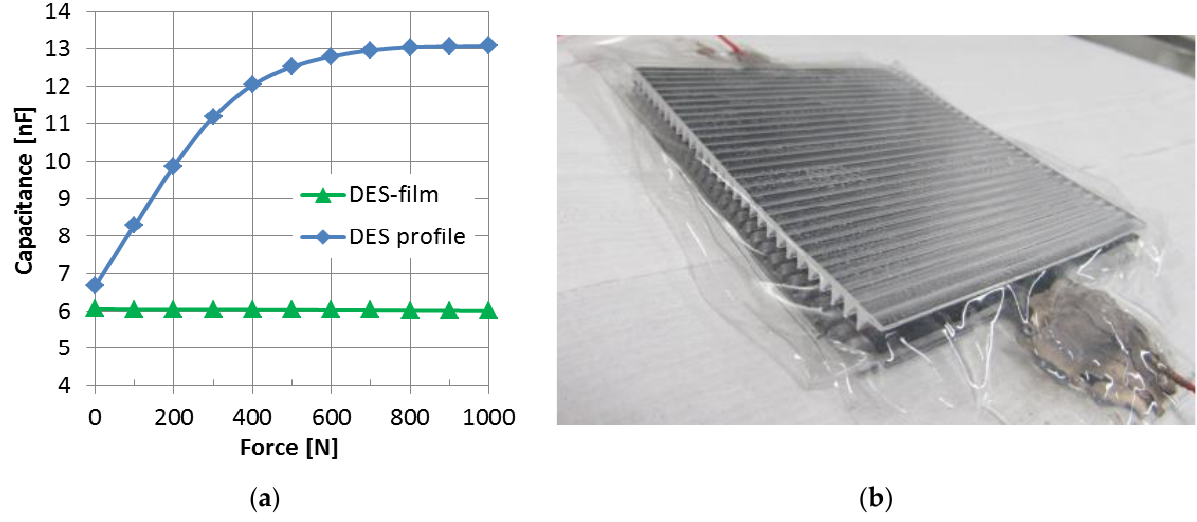
Figure 6. Dependence of the measured capacitance of a sensor with wave profiles and an intermediate DES film on the applied compression force compared with the corresponding curve of a pure DES film ( a ) and photograph of the sensor with wave profiles with an area of 100 mm × 100 mm ( b ) [99].